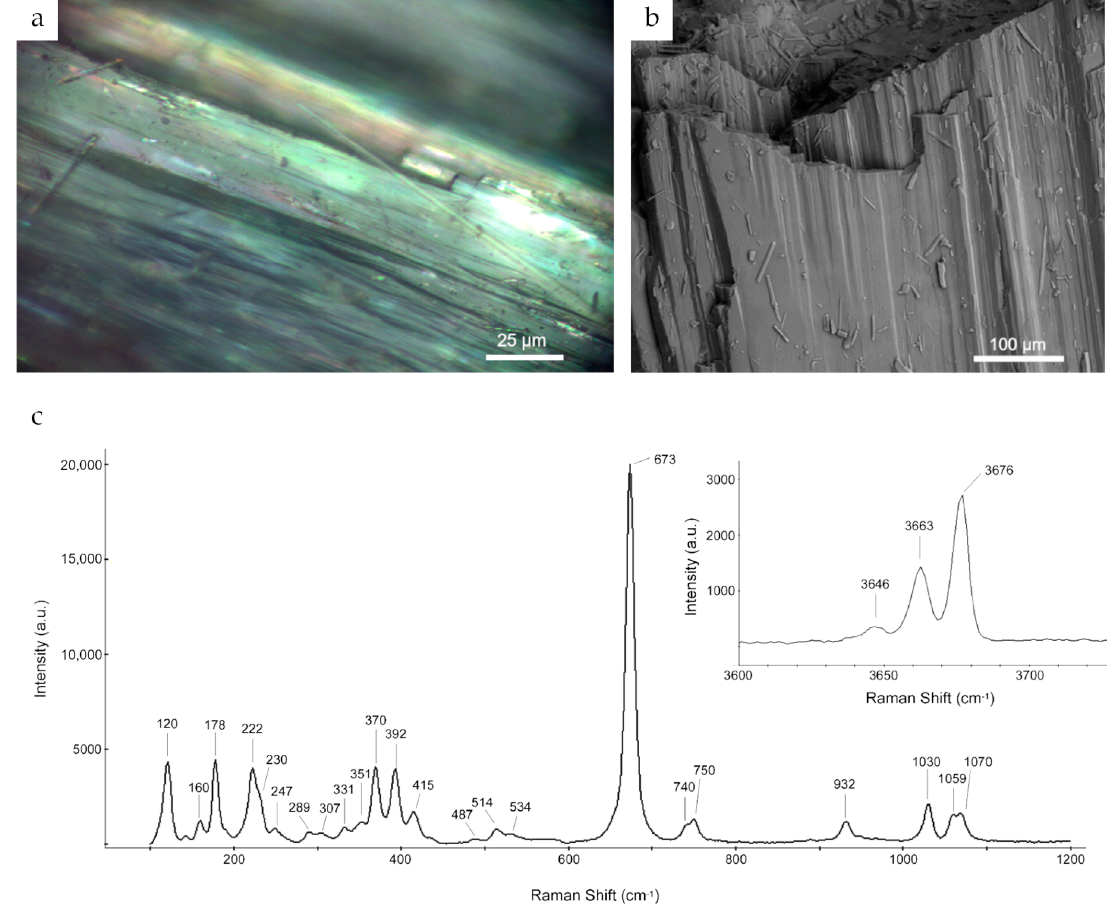
Figure 4. Sample #S3 ( a ) green columnar aggregates analyzed by µ -Raman spectroscopy; ( b ) SE image showing the same fragment; ( c ) µ -Raman spectra in the region 100–4000 cm − 1 .